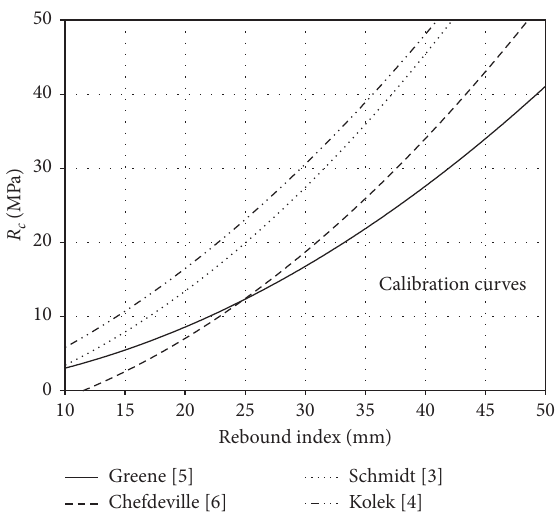
Figure 1: Calibration curves for the rebound hammer from